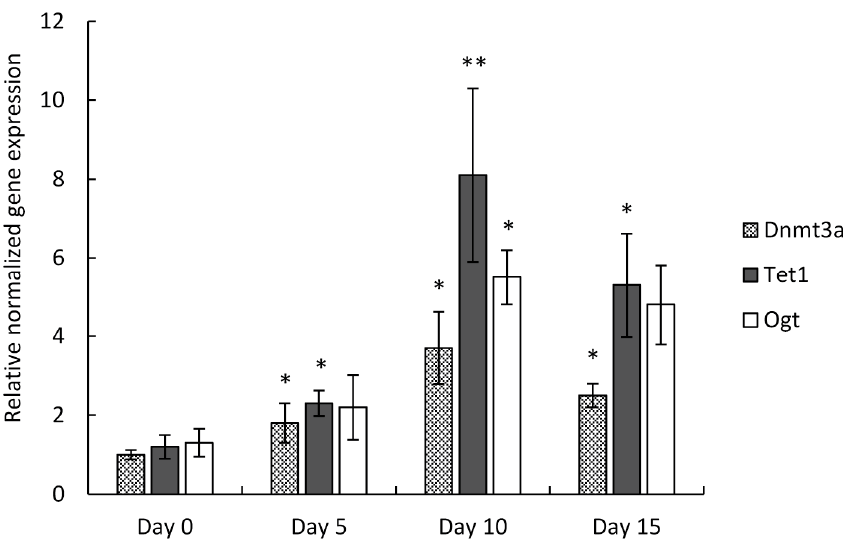
Figure 1. PCR array with micromass cultures established from C3H10T1/2 BMP-2 cells collected on designated days of in vitro cartilage formation. Chondrogenic differentiation-associated changes in the expression of epigenetic factors were visualized with a heatmap. The red squares refer to upregulated genes, and the green squares indicate downregulated genes. Genes next to the red line are mostly upregulated between the 5th and 10th days of culturing. Genes neighboring the blue line are upregulated around culturing day 15. Genes next to the green line are upregulated between the 10th and 15th days of culturing. Specific DNA methylation and demethylation regulator genes are marked with red arrows. Data indicated with the black rectangle: expressional changes of chondrogenic and osteogenic marker genes in order to verify the cartilaginous differentiation of micromass cultures.